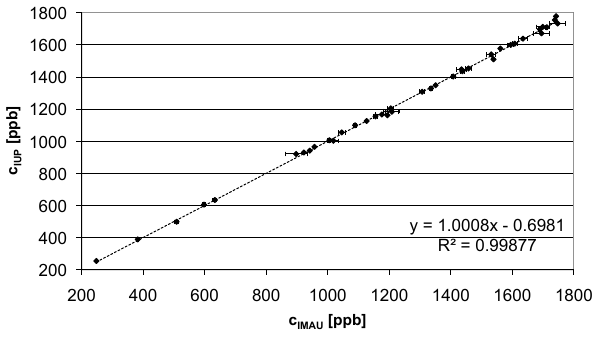
Fig. 9. Comparison of the concentrations for balloon flights B37- B39 measured with the GC-IRMS technique (x-axis) to the IUP results (y-axis). Usually an excellent linear correlation with a small offset is found.